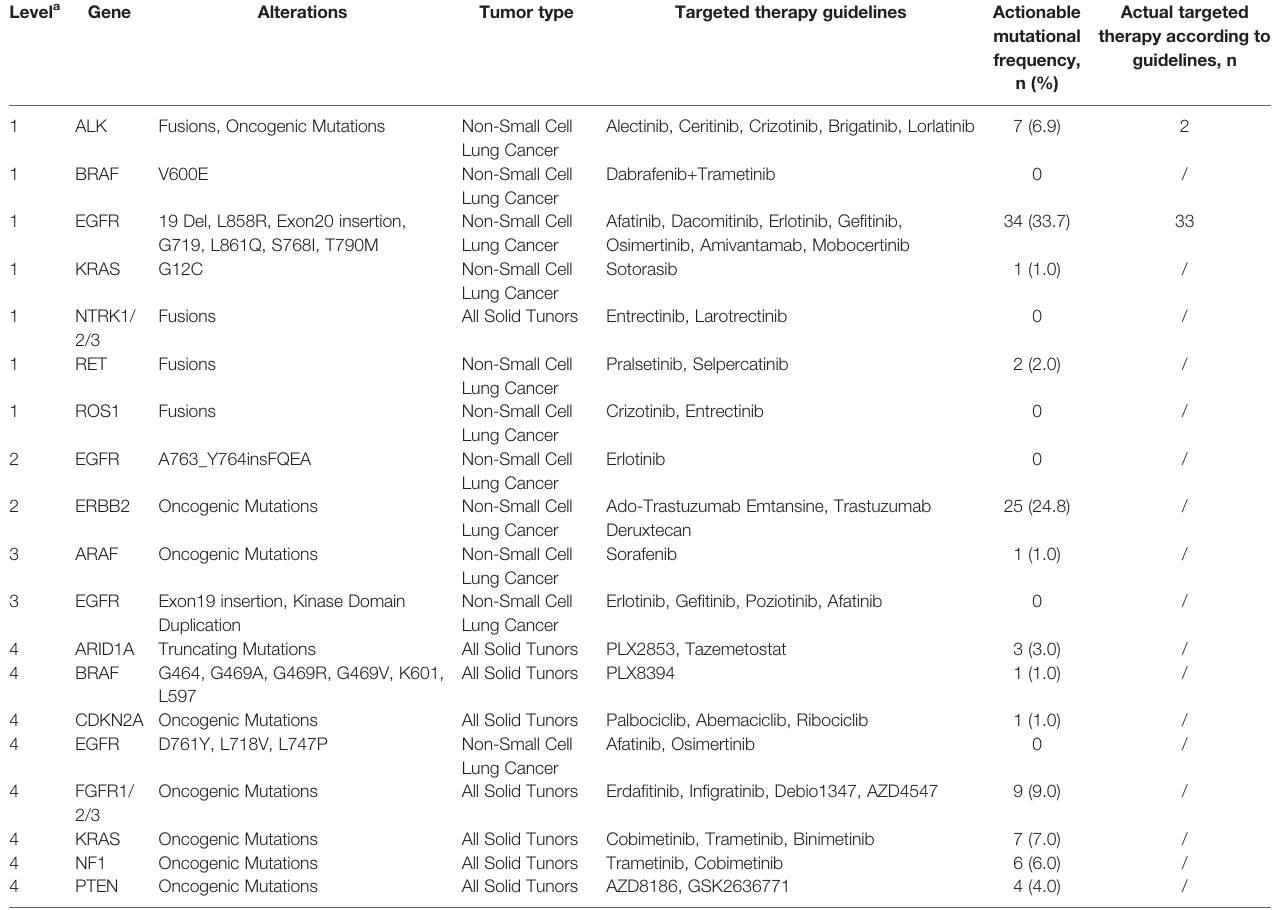
TABLE 1 | Mutated genes and actionable targeted